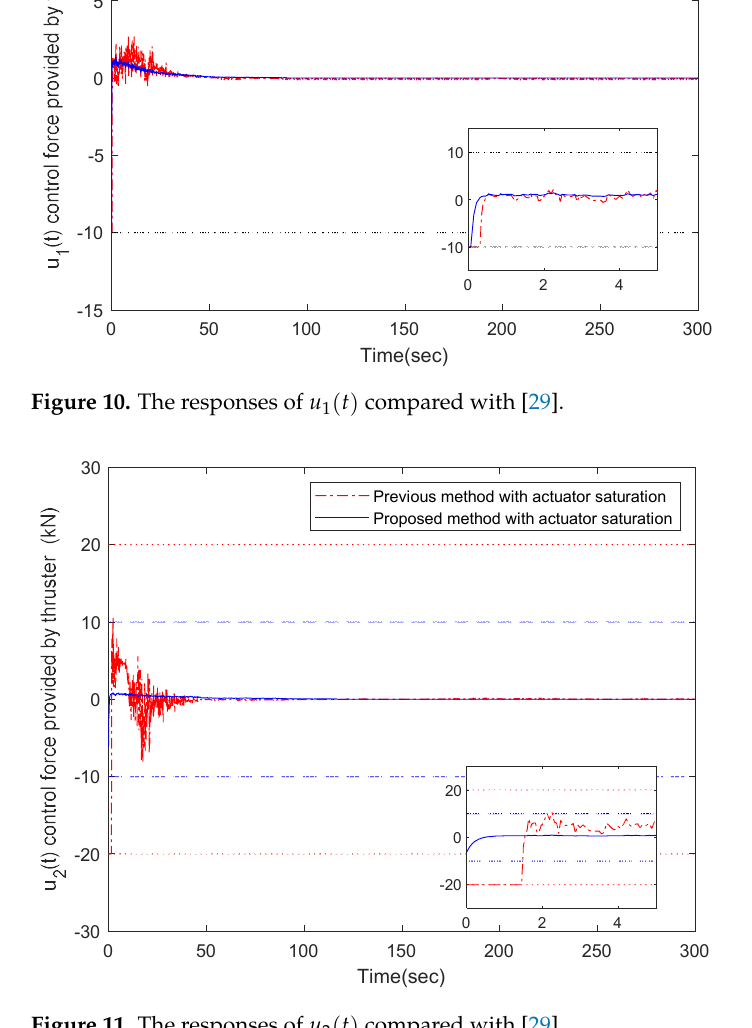
Figure 11. The responses of  